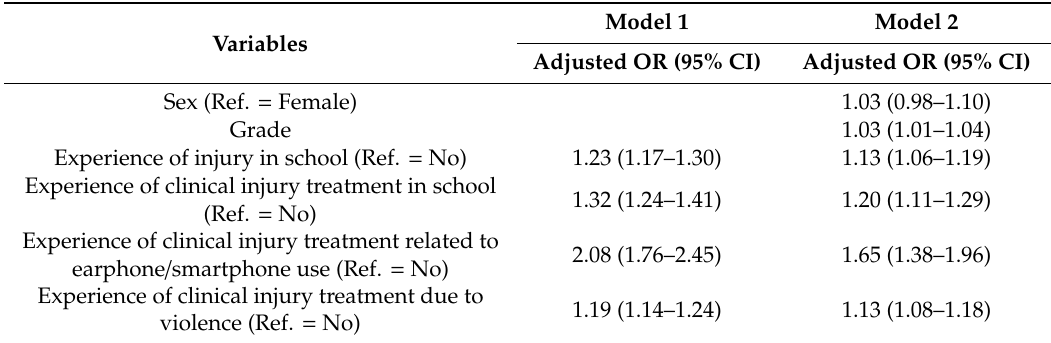
Table 7. The adjusted association of tooth fracture experience in the past 12 months with variables related to clinical treatment experience due to injury by a complex-sample multivariable logistic regression model.